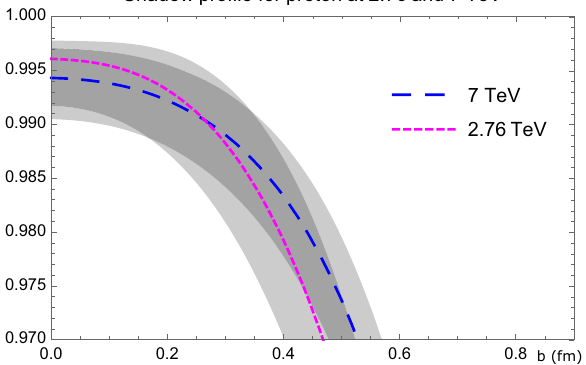
Fig. 5 The inelasticity (or shadow) profile function extracted from the TOTEM7TeVand2.76TeVdatasetsusingtheLévyexpansionmethod, together with the associated error bar, zoomed in around the peak value